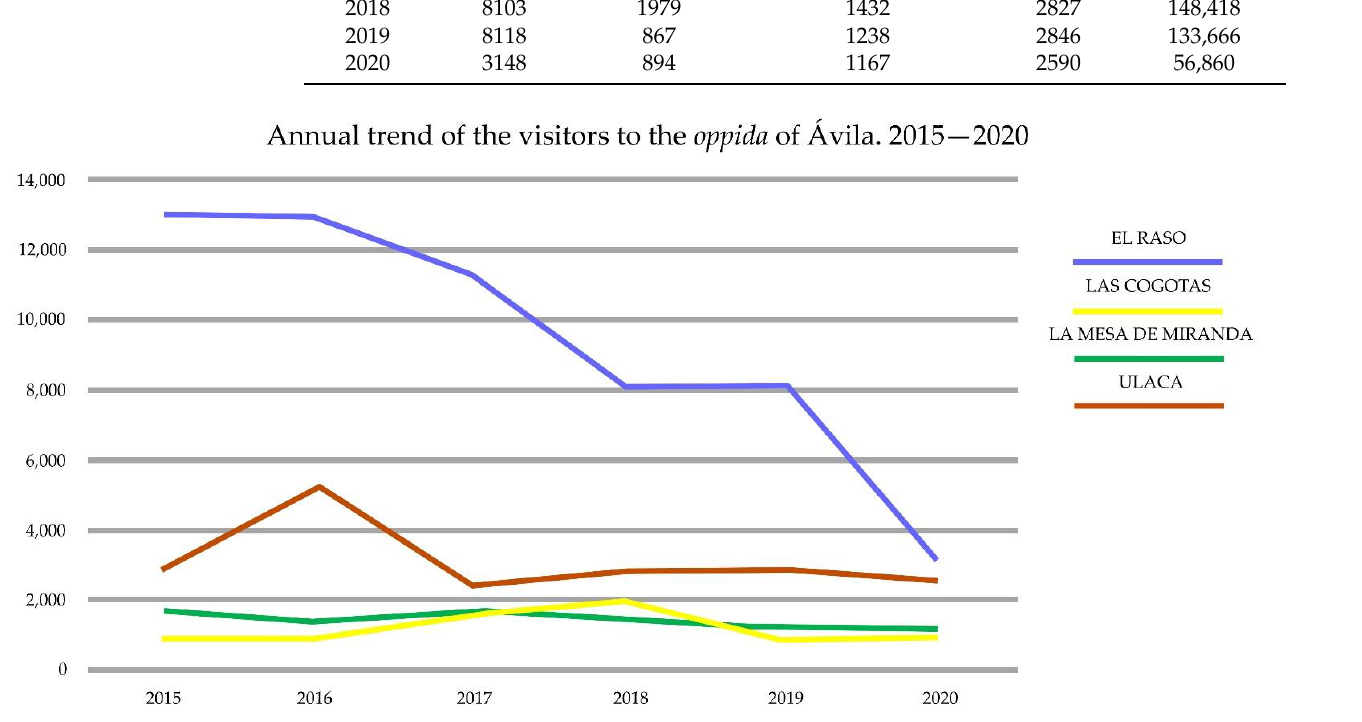
Figure 2. Graph about the dynamics of visitors to the oppida of Á vila (2015–2020). Source: Territorial Service of Culture of Á vila.